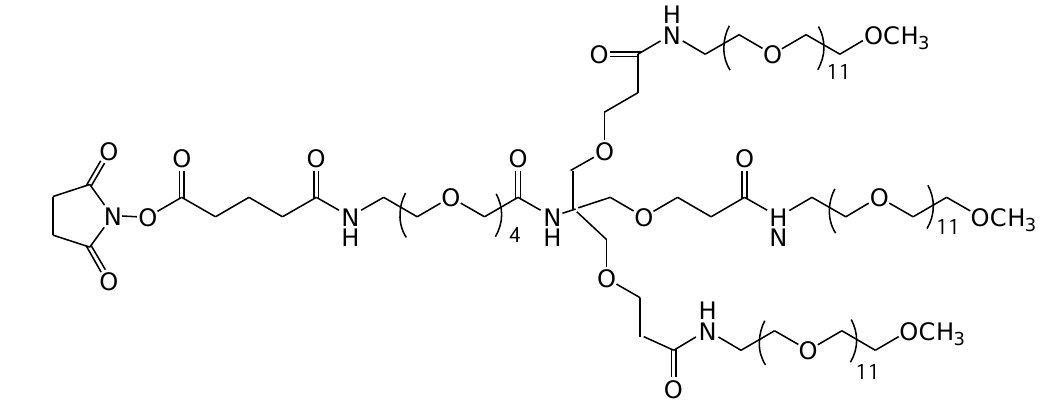
Figure 5. Chemical structure of the amine-reactive PEGylation reagent used (methyl-PEG ) -PEG -N-hydroxysuccinimide 12 3 4